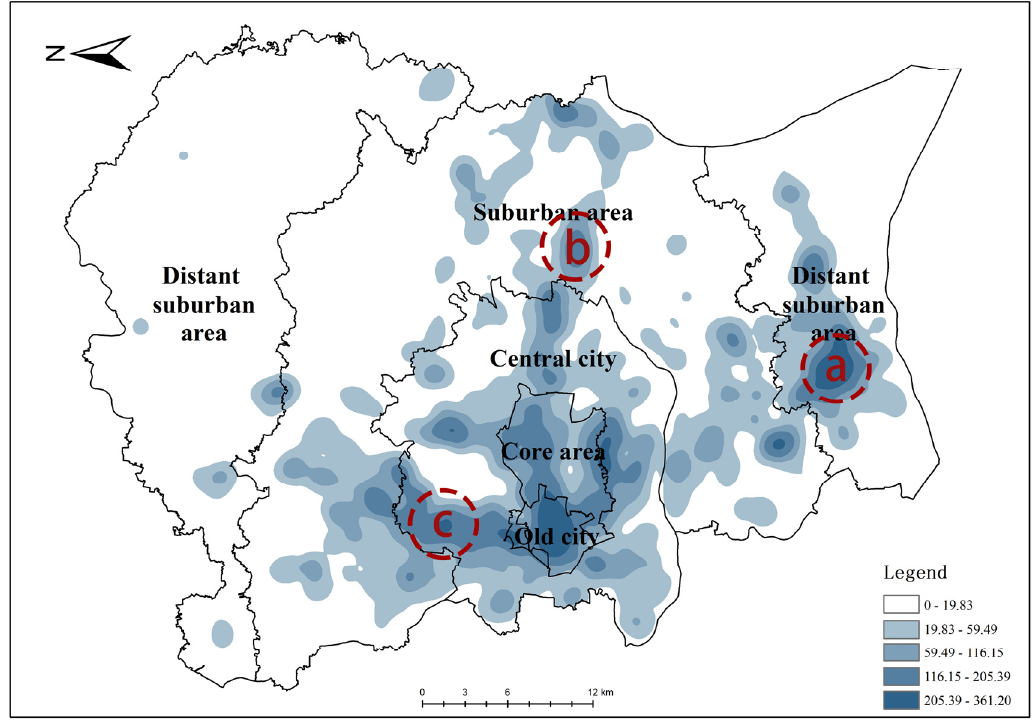
Figure 5. Schematic diagram of the spatial distribution of theft